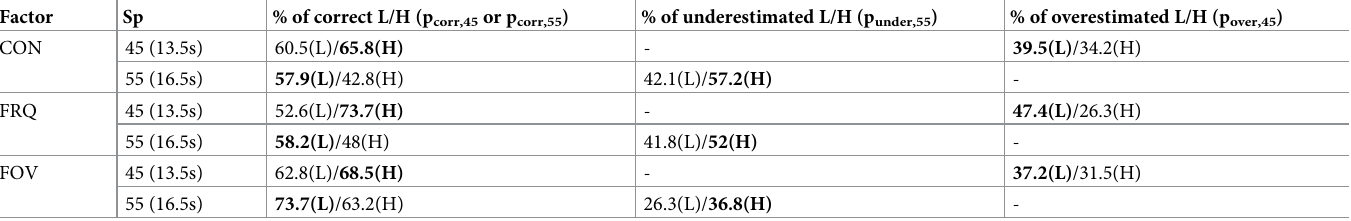
Table 2. Results of Experiment 1. Accuracy (% of correct answers) is higher for high magnitude levels of contrast, frequency and FoV at 45% sp (“less than half” answers), while at 55% sp (“more than half” answers) it is always higher for low magnitude levels of contrast and frequency. At 45% sp, overestimation (incorrect responses, “more than half” answers) occurs more frequently for low magnitude levels. At 55% sp, underestimation (incorrect responses, “less than half” answers) occurs more frequently at high magnitude levels. Factor Sp % of correct L/H (p corr,45 or p corr,55 ) % of underestimated L/H (p under,55